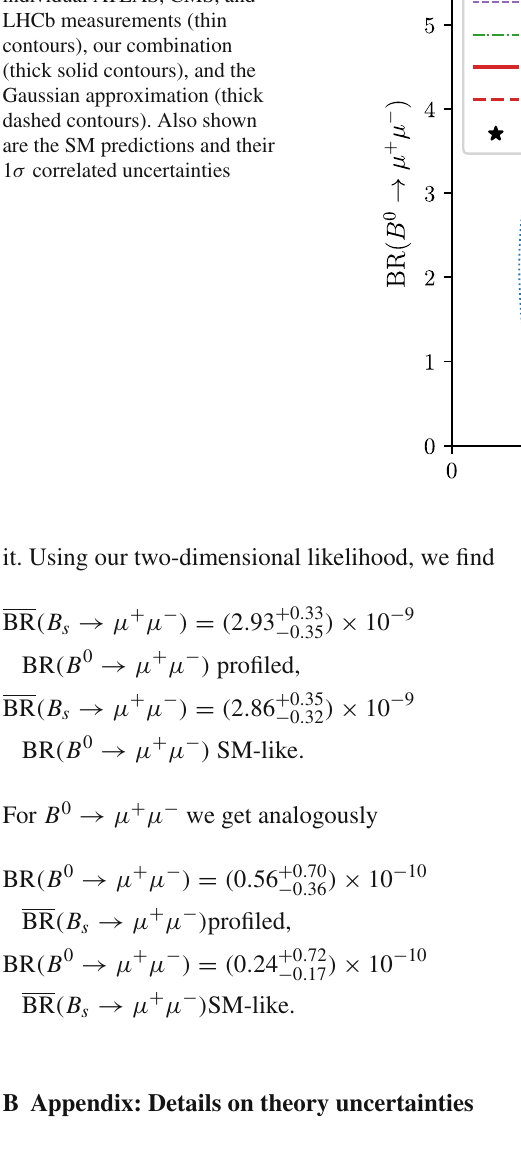
Fig. 11 Likelihood contours in the plane of BR ( B 0 → μ + μ − ) and BR ( B s → μ + μ − ) from the individual ATLAS, CMS, and LHCb measurements (thin contours), our combination (thick solid contours), and the Gaussian approximation (thick dashed contours). Also shown are the SM predictions and their 1 σ correlated